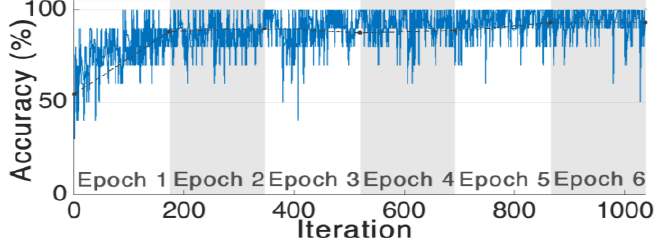
Figure 7. GoogLeNet training accuracy.